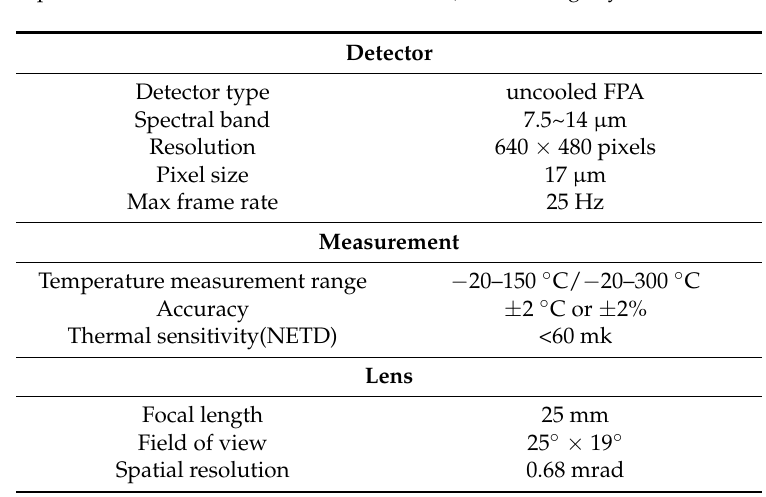
Figure 2. XM6 thermal camera used in this study. (Source: Magnity Electronics Co., Ltd.) Table 2. Specifications of the XM6 thermal camera. (Source: Magnity Electronics Co., Ltd.)